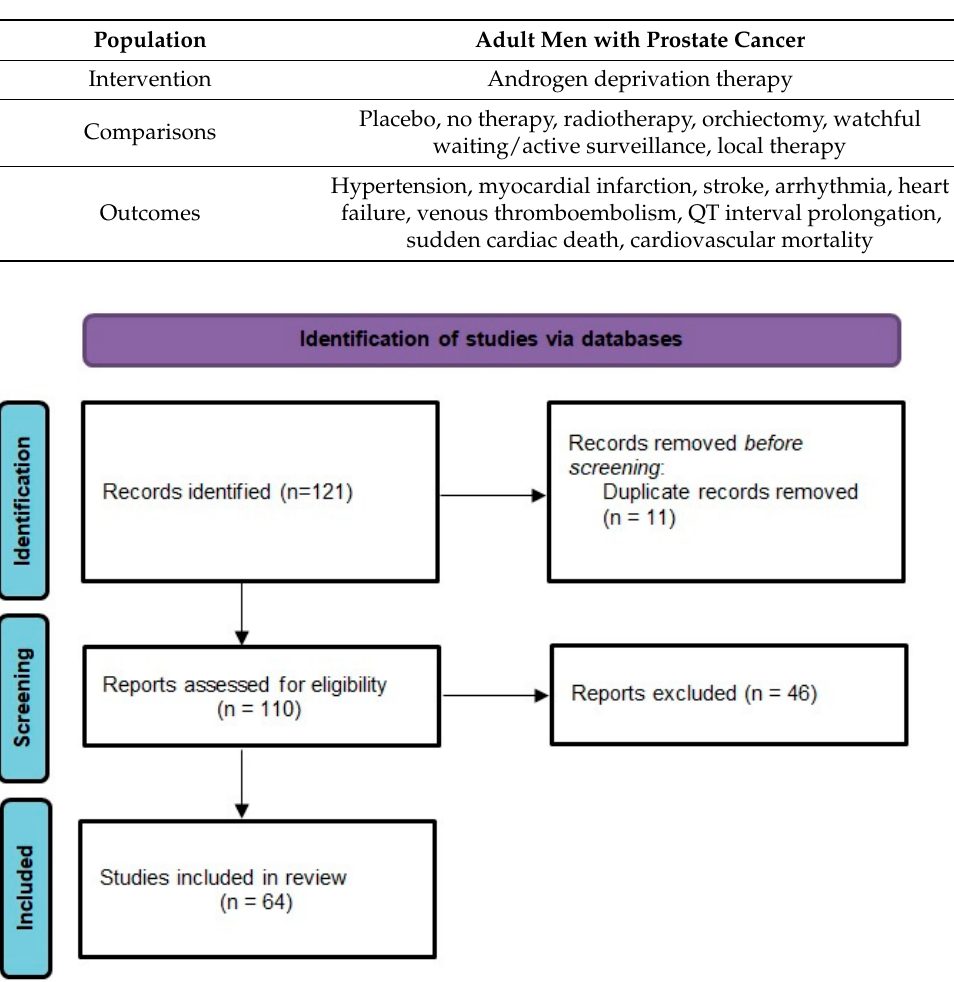
Table 2. Inclusion criteria for the current narrative review.